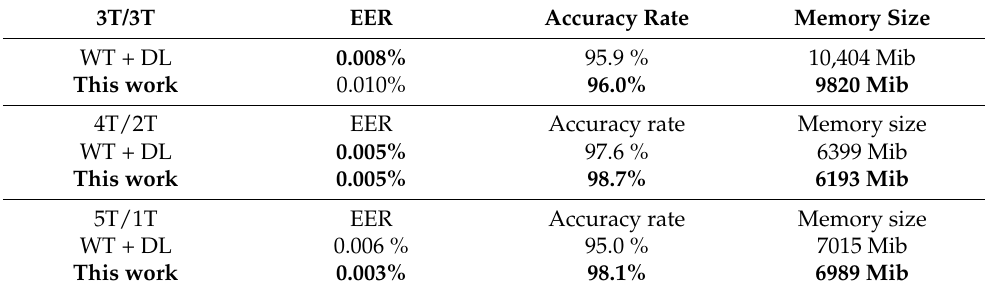
Table 2. Identification stability for three vein image analysis setups using the SDUMLA-HMT dataset. 3T/3T